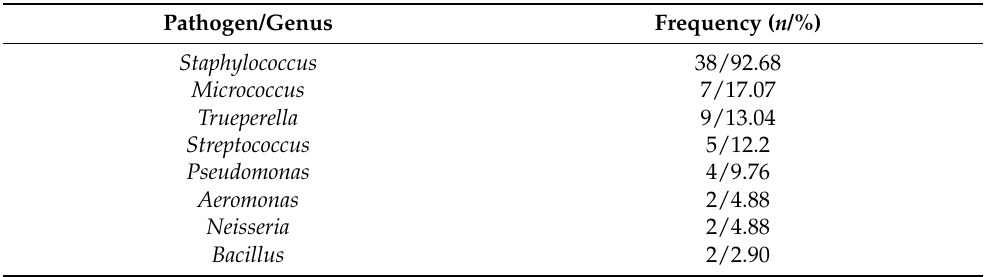
Table 1. The prevalence of bacterial genera identified in ocular secretion in Saint Bernard dogs.